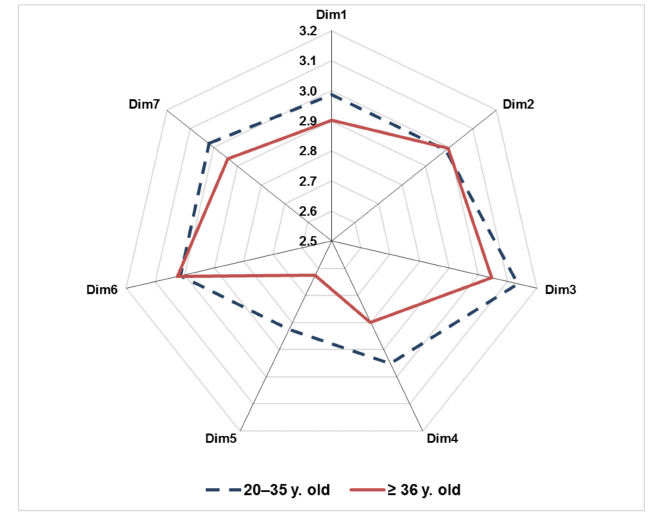
Figure 6. Scores obtained by farmers di ff erentiated based on the age (workers 20–35 years old, dotted line; workers older than 35 year old, solid line).